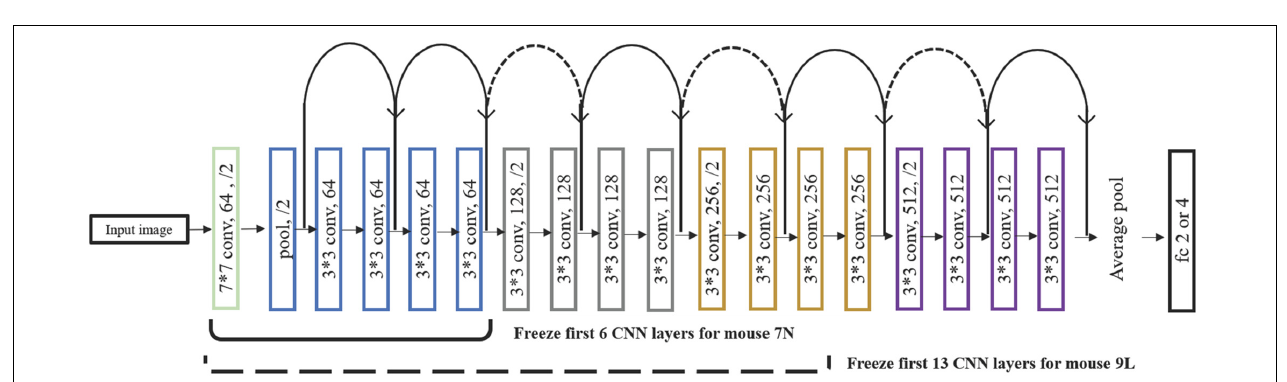
FIGURE 3 | The five-fold data separation procedure. The calcium imaging data recorded in each day was randomly partitioned into 5 portions. One portion was chosen as the testing dataset and the remaining data were used as training dataset. The classification experiments were repeated for 5 times.